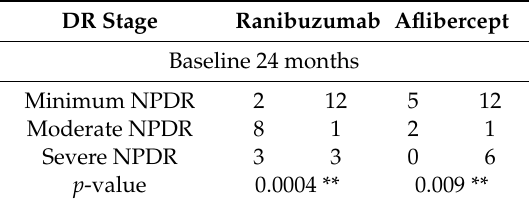
Table 2. Diabetic retinopathy severity